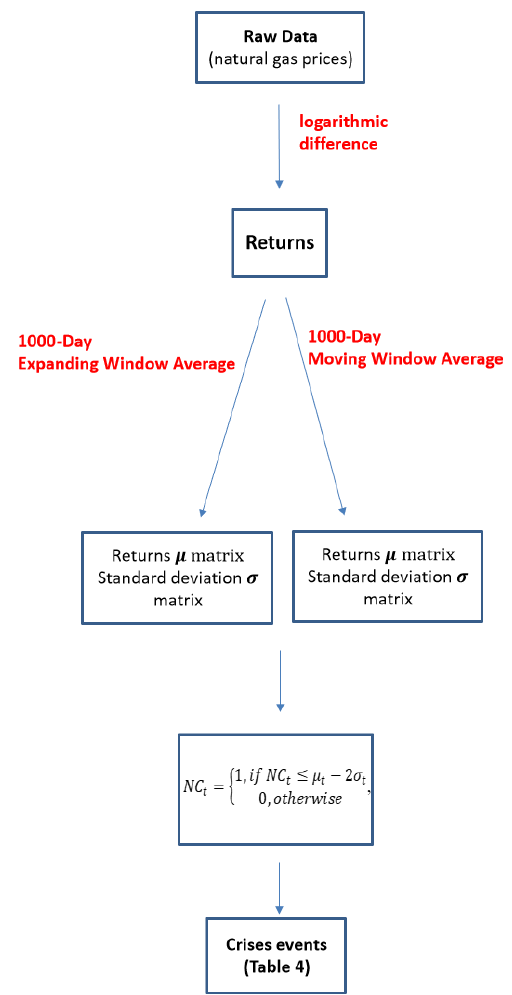
Table 4. Crisis events in the US natural gas market.